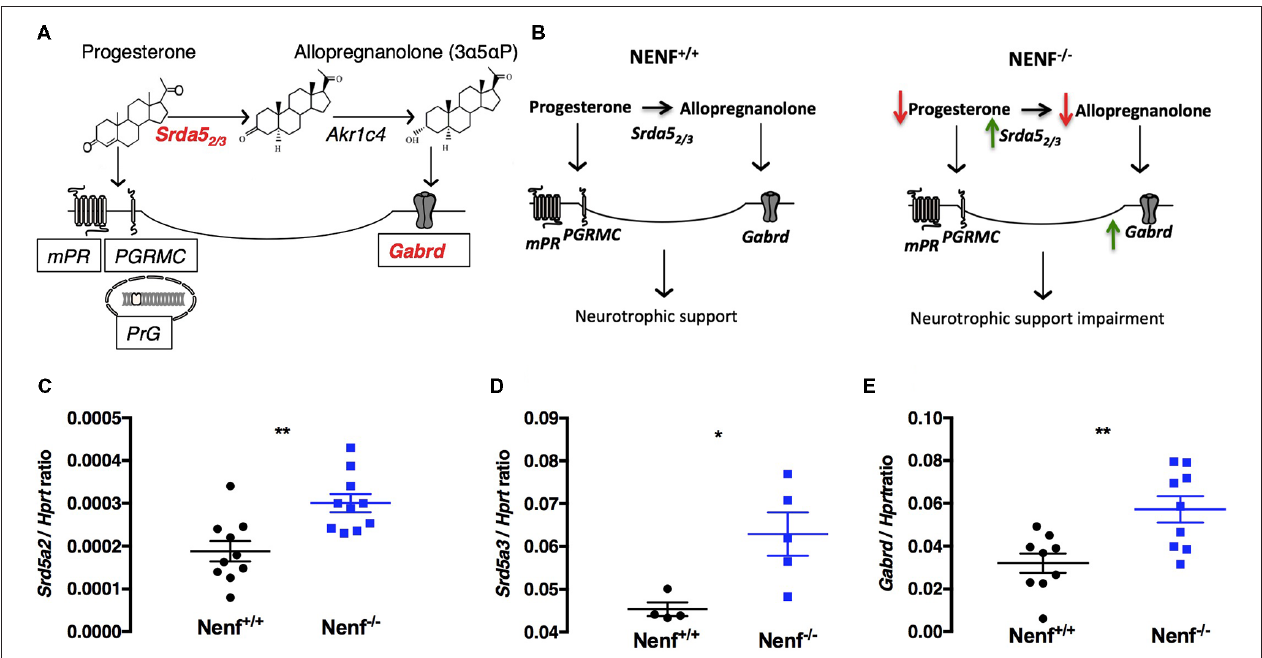
FIGURE 5 | Ablation of NENF alters steroid metabolism in the DG. Schematic representation of progesterone metabolization into neurosteroids and the respective binding receptors (A) . Proposed mechanism for the role of NENF neurotrophic support in the DG (B) . Since NENF is a membrane-associated progesterone receptor family (MAPR) protein, progesterone metabolism gene expression was assessed in the DG. Srd5a2 and Srd5a3 were found increased in Nenf − / − (C,D) . Progesterone is the main source of active steroids in the brain that bind to GABA A receptors with a delta subunit, we aobserved an overexpression of Gabrd gene in the DG in the absence of NENF (E) . Data presented as Mean ± SEM; analyzed by two-tailed Student’s t -test ∗ p < 0.05 and ∗∗ p < 0.001. Hypoxanthine guanine phosphoribosyl transferase ( Hprt ), 5-alpha-reductase 2 and 3 gene ( Srd5a2 and Srd5a3 ) and gamma-aminobutyric acid A receptor, delta gene ( Gabrd ), 3 α -hydroxysteroid dehydrogenase gene ( AKR1C4 ), progesterone membrane receptor (mPR), progesterone receptor membrane component 1(PGRMC1), nuclear progesterone receptor